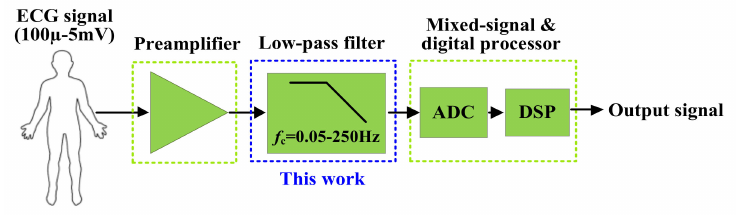
Figure 1. Electrocardiogram acquisition system.